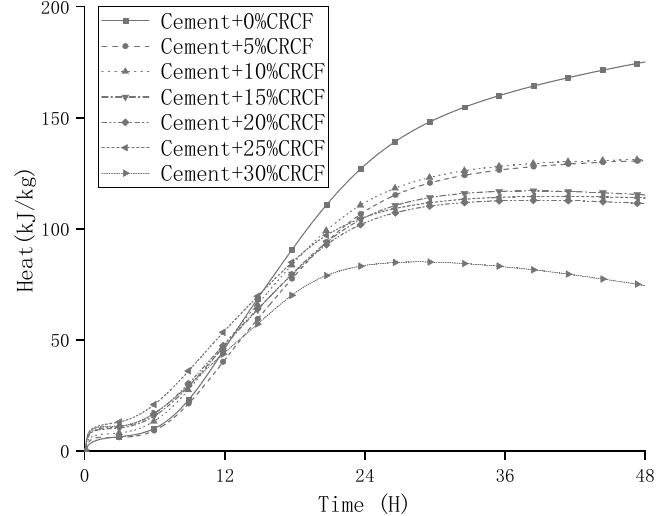
Figure 11. The cumulated heat of hydration of paste samples with different CRCF contents. To further explore the in fl uences of CRCF on cement hydration, the Krstulovi ć –Dabi ć kinetics model was utilized in this research, which is the widely used hydration kinetic model [48,49]. The model divides the hydration process into three stages according to the